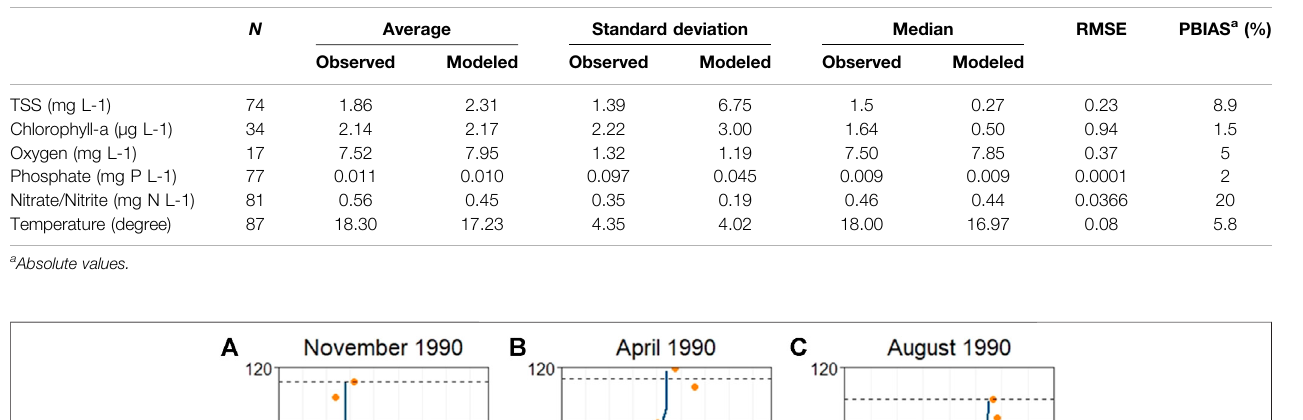
TABLE 3 | Statistical analysis for water quality parameters.